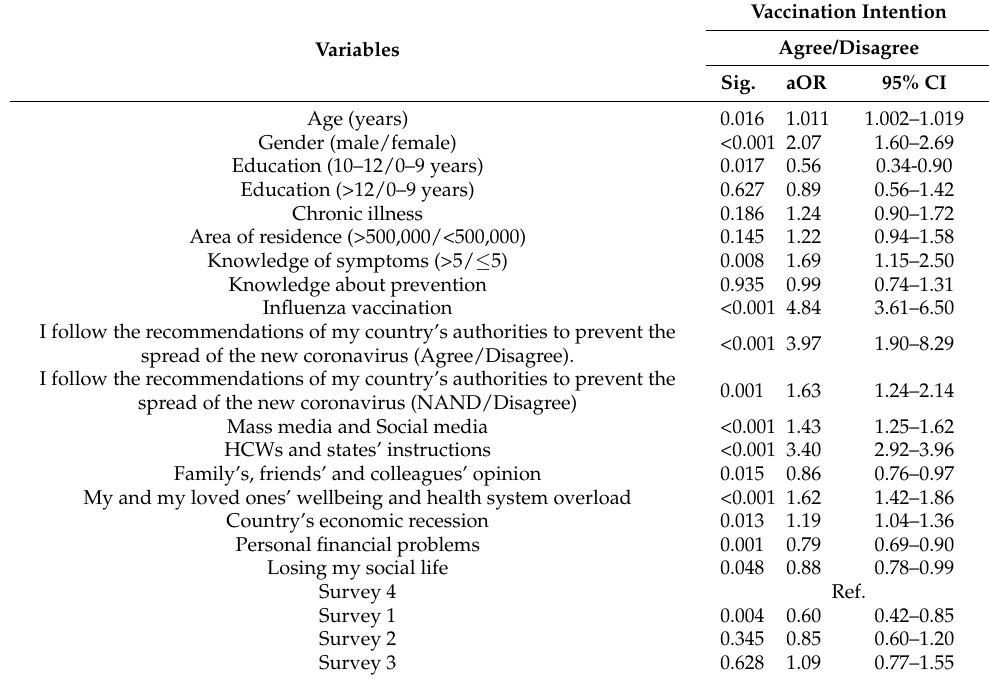
Table 4. Multivariate analysis, vaccination intention, data from surveys